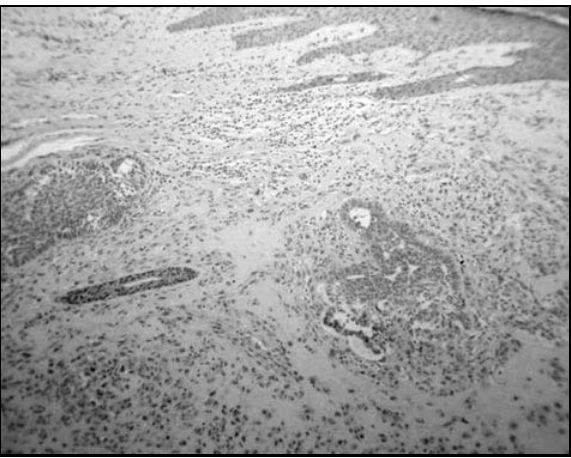
Figura 2 – Predomínio do componente epitelial na periferia do tumor (H&E, 100x)